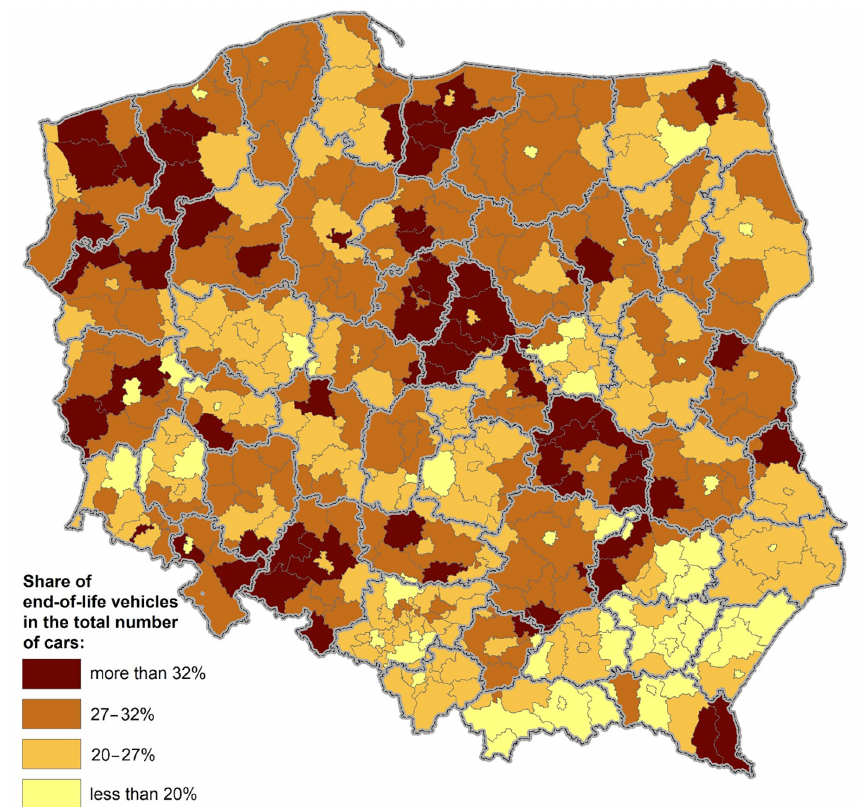
Fig. 3. Spatial distribution of end-of-life cars in Polish districts (as at 31 December 2018), in line with the country’s former administrative division into 49 provinces (1975–1998). Source: authors’ own elaboration based on CEP